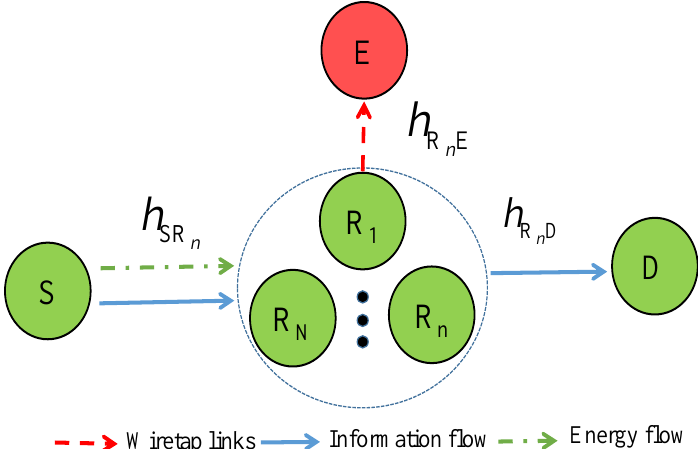
Figure 1. SWIPT-based cooperative relay networks in the presence of an